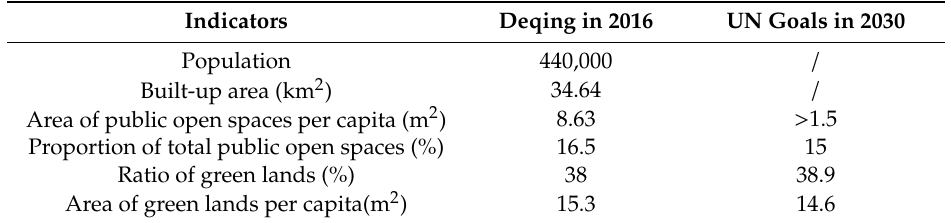
Table 2. The assessment results of urban public open spaces by SDG 11.7.1 in Deqing’s built-up